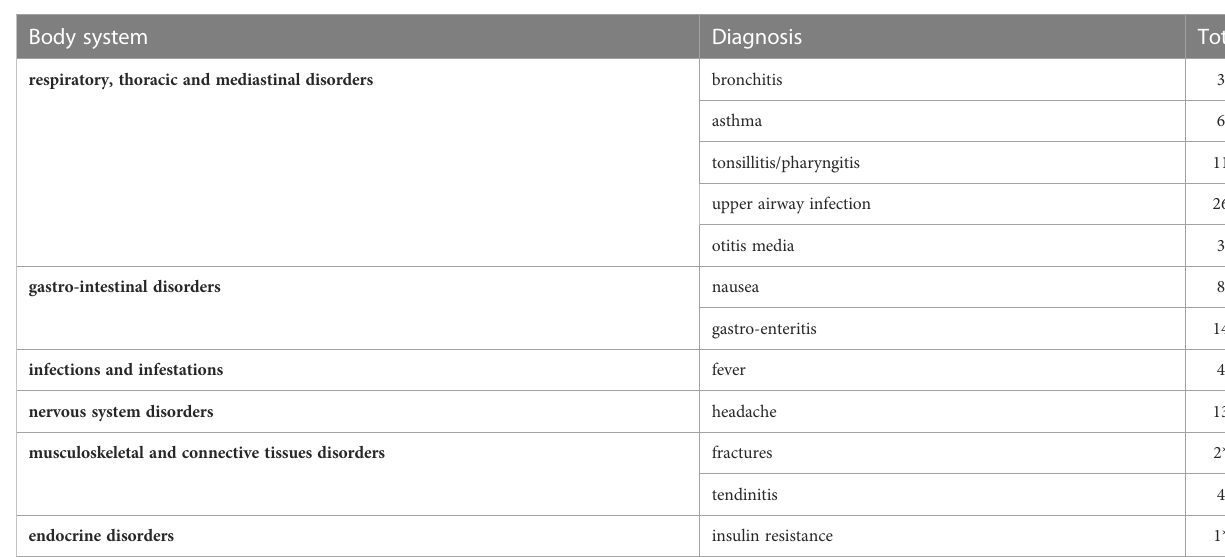
TABLE 3 Adverse events according to body system occurring more than